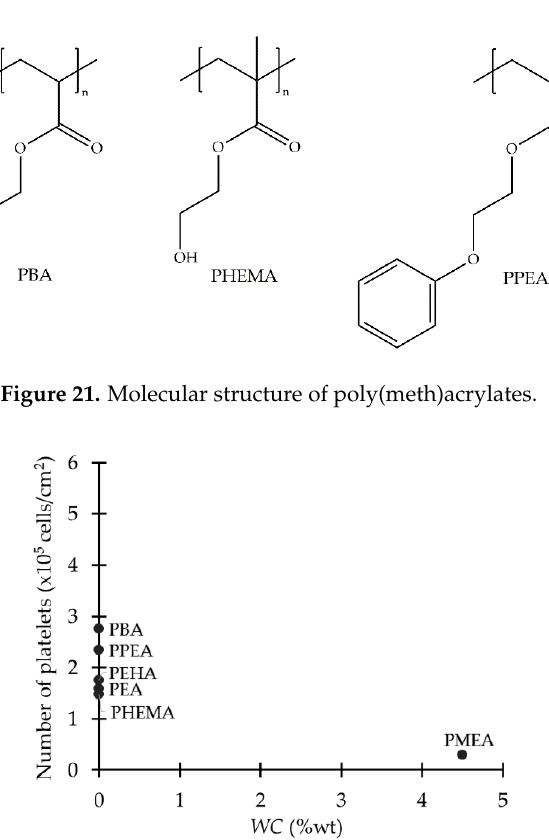
Figure 22. Relation of intermediate water content and platelet adhesion in poly(meth)acrylates. Data extracted from [77].